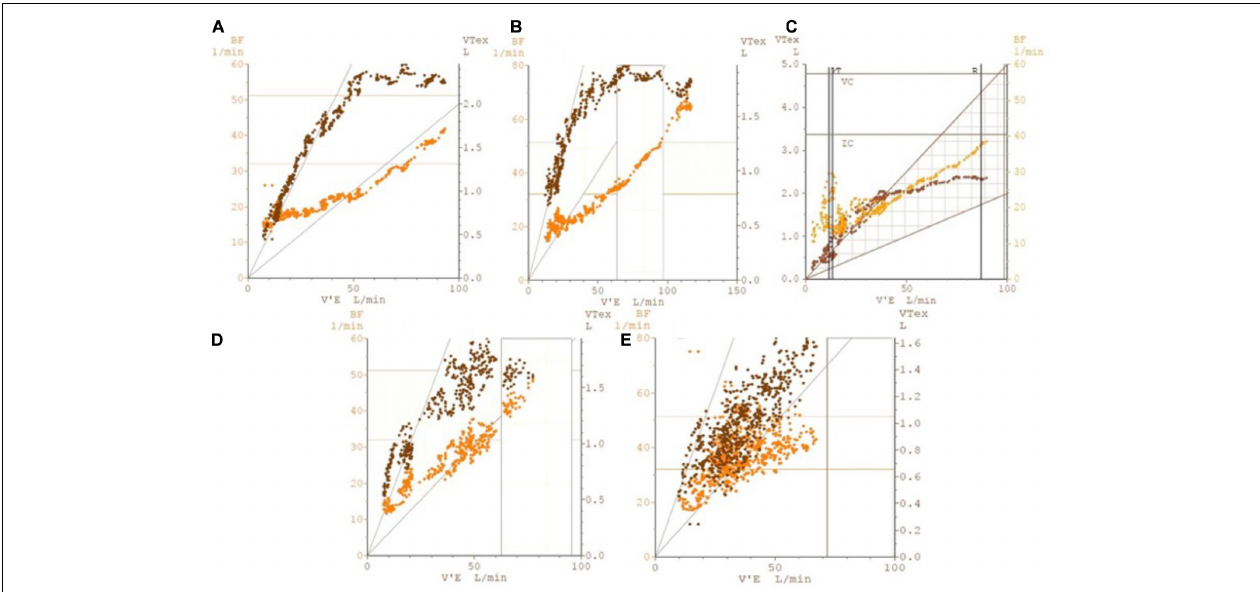
FIGURE 2 | Illustrative plots of breathing frequency (labeled as BF on left y -axis) and tidal volume (labeled as VTex on right y -axis) against minute ventilation (labeled as V’E on x -axis), showing breathing pattern responses to ramp-incremental CPET in five possible scenarios. Such plots allow for greater insight into the breathing pattern over the course of the CPET, looking at both V t and B f changes with ventilation. The five scenarios illustrated are: (A) normal individual (B) athletic individual (C) early DB that resolves on exercise (D) DB manifesting upon commencement of exercise (E) DB throughout. Particular attention should be paid to the predictable pattern of breathing frequency and tidal volume increases in plots (A,B) , allowing for an efficient mechanism for minute ventilation to increase; this can be contrasted to the erratic patterns that can be observed in plots (C–E) , which are indicative of DB. BF, breathing frequency; V’E, minute ventilation; VTex, tidal volume.